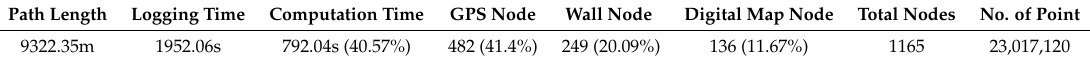
Table 4. Summary of Digital-Based SLAM results